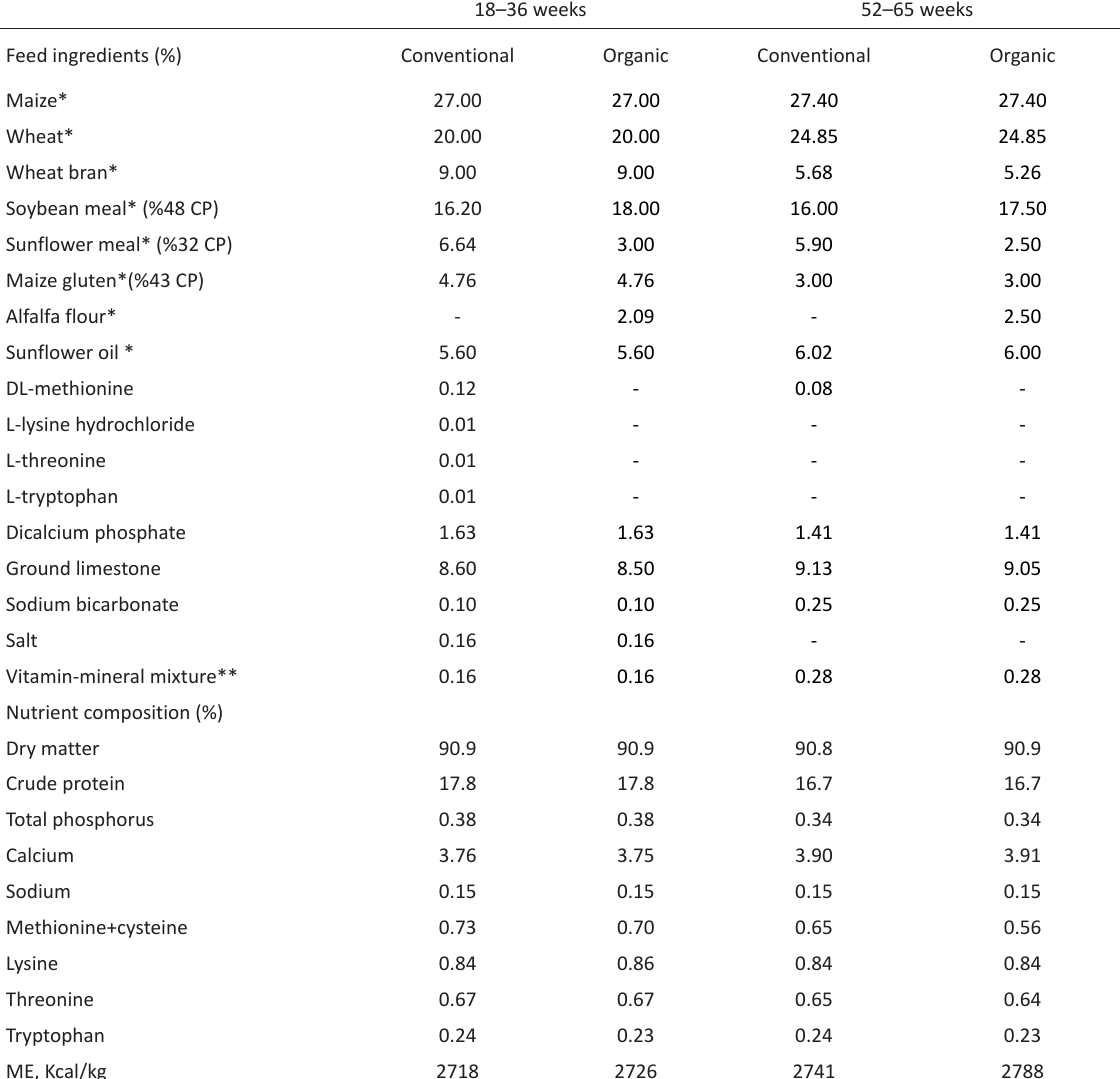
Table 1. Composition of conventional and organic feeds in studied laying periods 18–36 weeks Feed ingredients (%) Conventional